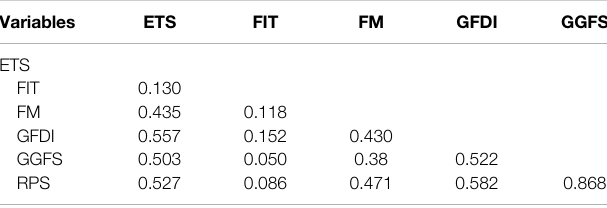
TABLE 4 | Heterotrait – monotrait ratio.